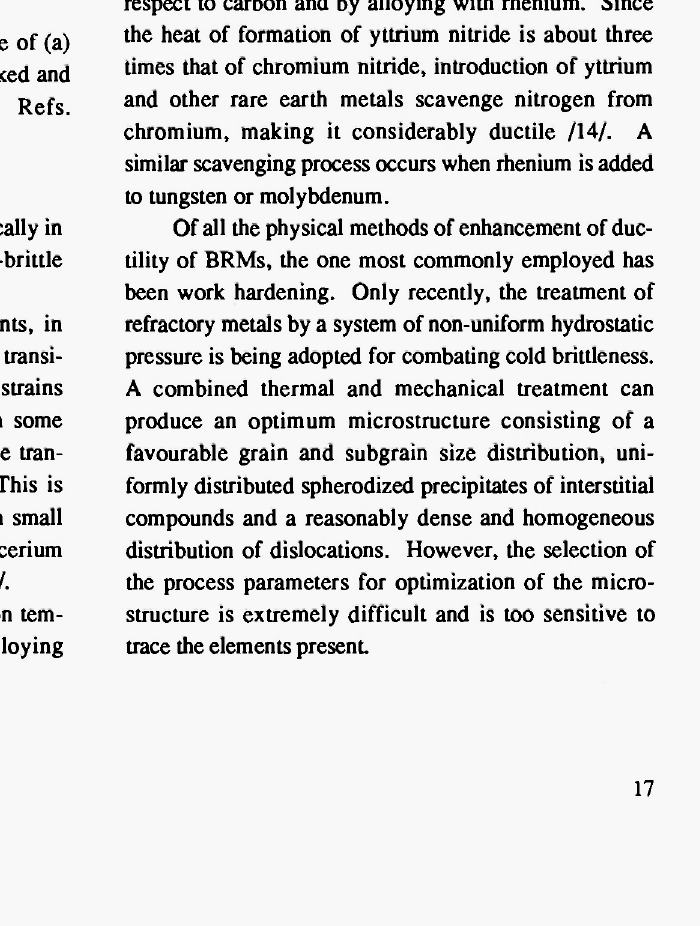
Fig. 9: Ductile-brittle transition temperature of (a) Mo-Re and (b) W-Re alloys in worked and recrystallized conditions (from Refs.